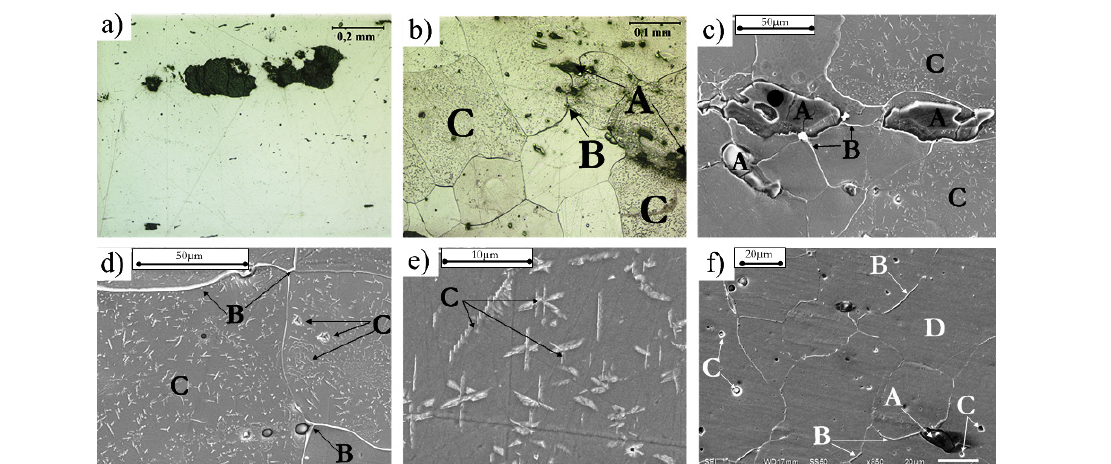
Figure 4: Microstructure of investigated puddled steel (1899-1904) – marked as S-steel, in (a) post-operating state (light microscopy) – presented nonmetallic inclusions typical for puddled steel, (b) post-operating state; ferrite grains with numbers of nonmetal inclusions